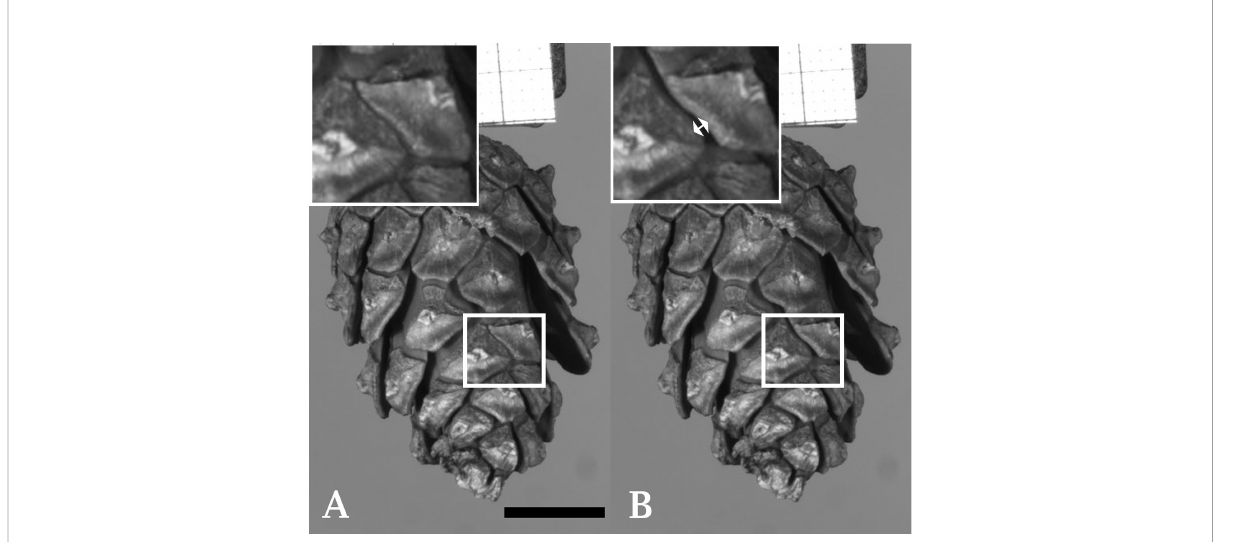
FIGURE 1 Cracking of an individual seed scale of Scots pine ( Pinus sylvestris ). (A) Shows a cone with a highlighted region prior to cracking. Several other scales of the cone have already started to bend. (B) Shows the cone after cracking (duration ~2 ms) of a single scale took place (indicated by a double arrow in the enlarged image of the highlighted region). Frames taken from Supplementary Video S8. Scale bar = 1